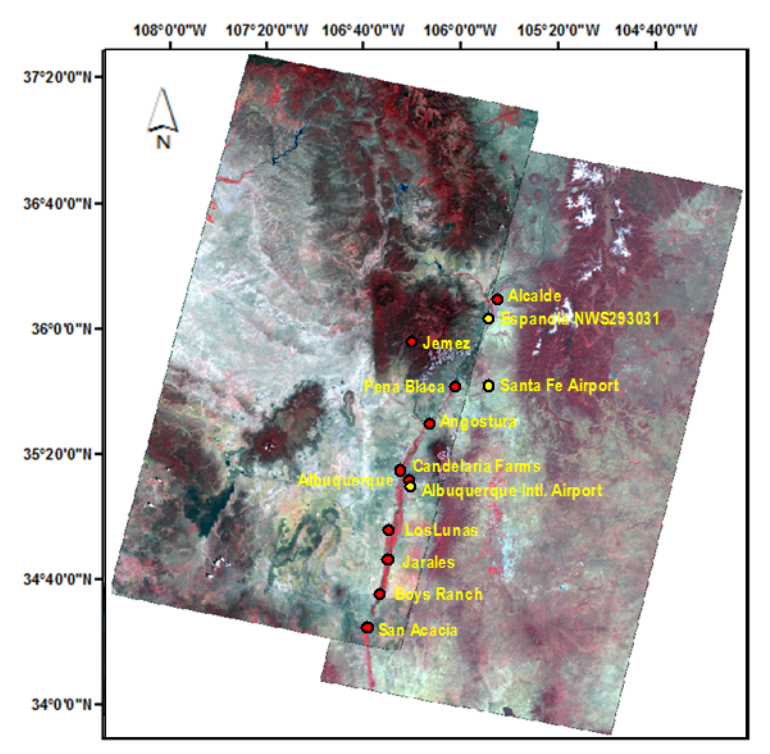
Figure 5. “False color” Landsat images for WRS-2 Paths 33 and 34, rows 34–36, of Landsat showing locations of weather stations along the Middle Rio Grande. Vegetated areas along the MRG river corridor are displayed as the bright red vertical strip in the image center. This area approximates the one processed using MODIS imagery.